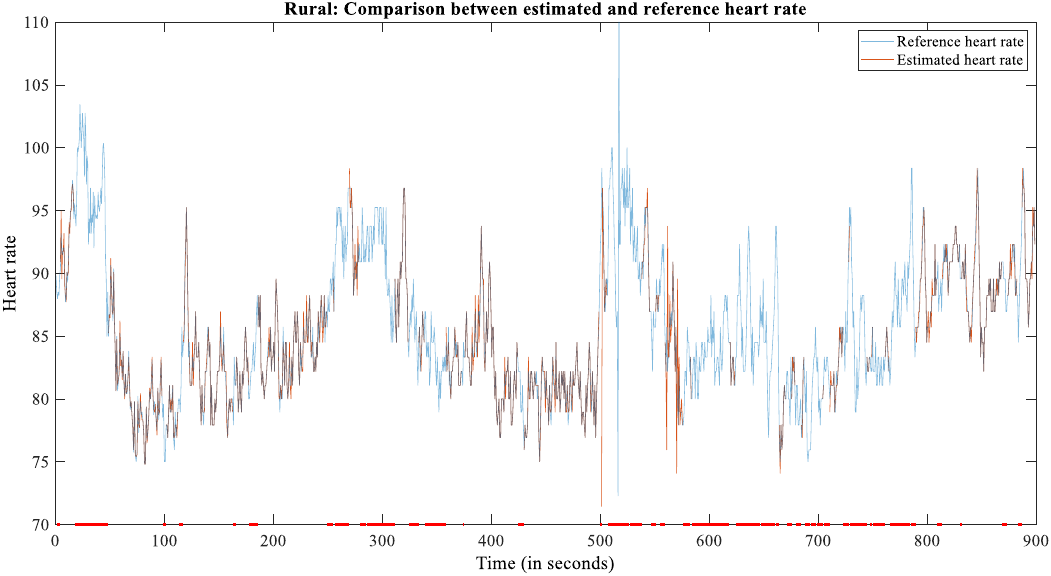
Figure 8. The plot of reference and estimated HR for subject 2209 during the rural scenario.